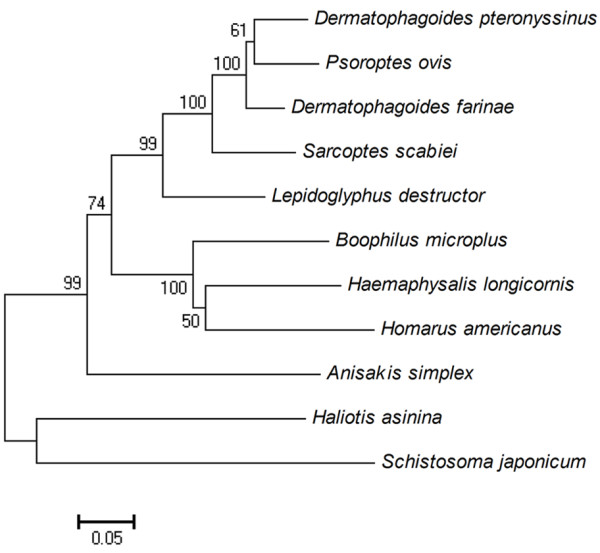
Neighbor-joining phylogenetic tree of selected tropomyosin proteins. GenBank accession numbers for each sequence are as follows: Homarus americanus, AF034954; Haemaphysalis longicornis, AF534184; Dermatophagoides pteronyssinus, D17682; Dermatophagoides gallinae, AM167555; Schistosoma japonicum, L76203; Boophilus micoplus, AF124514; Psoroptes ovis, AM114276; Anisakis simplex, Y19221; Lepidoglyphus destructor, AJ250096; Haliotis asinina, AY320360; Sarcoptes scabiei, JF922117. The percentage of support from 1000 bootstrap replicates is indicated at the nodes. Phylogenetic analysis was conducted using MEGA 4.0 [25].